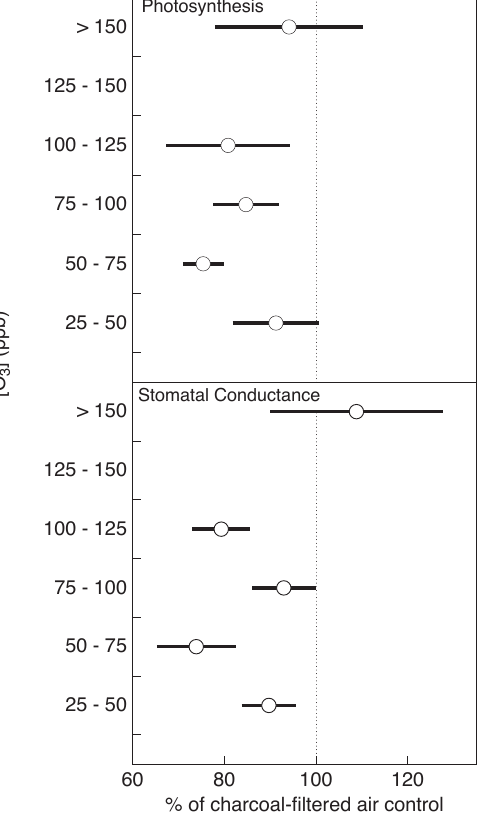
Fig. 5. Mean photosynthesis and stomatal conductance responses for plants exposed to chronic O 3 relative to control plants exposed to charcoal-filtered air, grouped by the O 3 concentration during exposure. Responses values are reported as % of control (treat- ment/control) and are plotted with 95% confidence